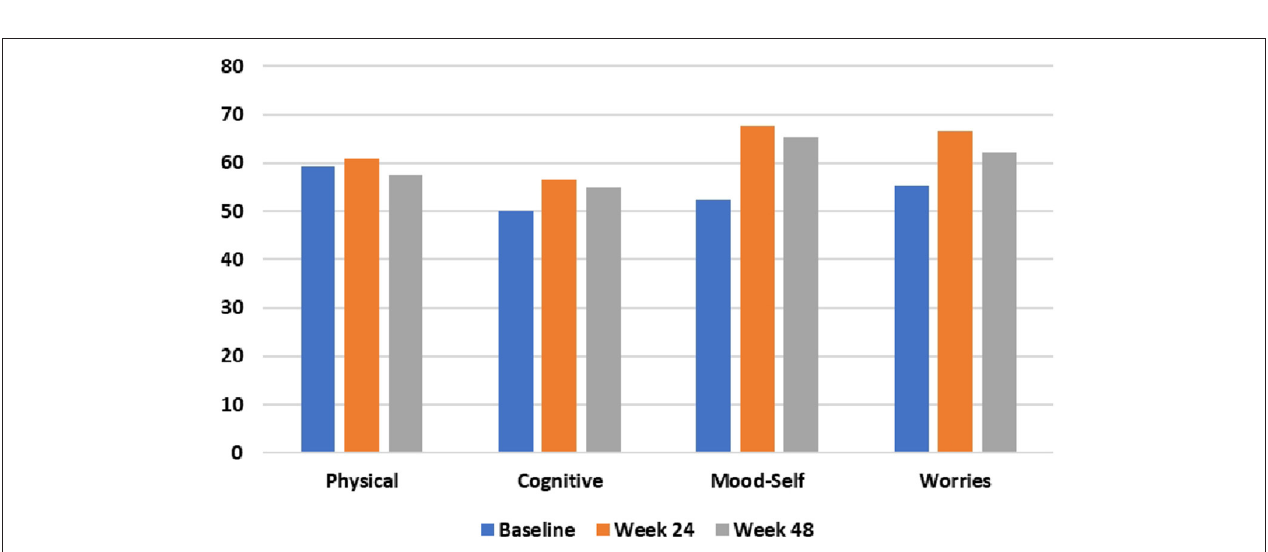
FIGURE 2 | Problem-behaviors assessment—short form (PBA-s) outcomes at baseline, 24 weeks, and 48 weeks after commencing the time-restricted ketogenic diet (lower numbers indicate improved behavior).